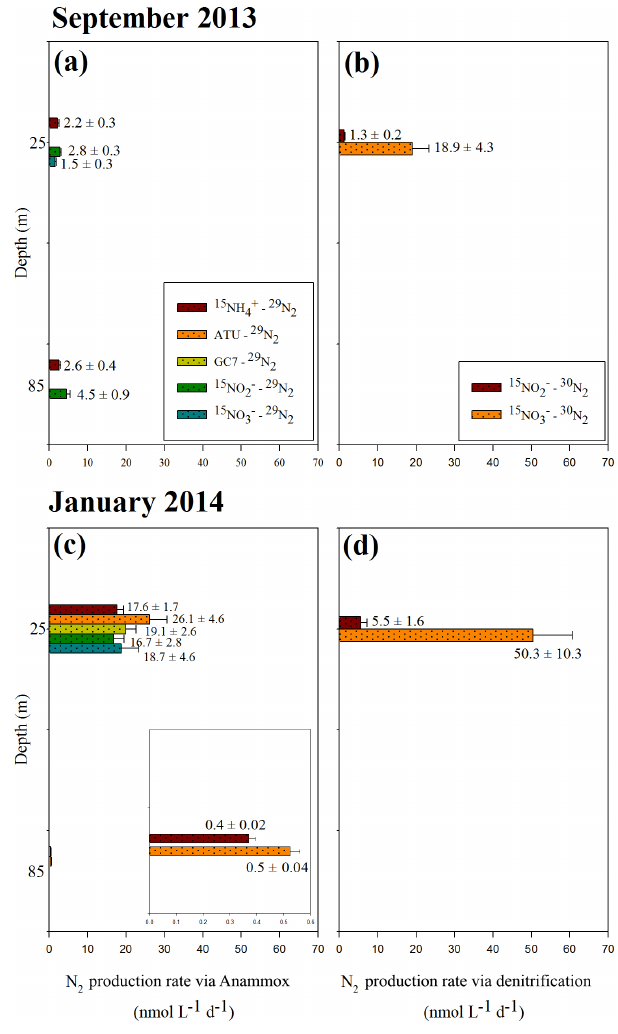
Figure 3. Anammox (a, c) and denitrification (b, d) activities ex- pressed as N 2 production rates measured in the oxycline (25m depth) and bottom layer (85m depth) at Sta. 18 over the continental shelf off central Chile during 12 September 2013 (a, b) and 28 Jan- uary 2014 (c, d) . Conventions show the amended tracer ( 15 NH + 15 NO − ) , isotopic pairing in the gas produced, and in- , and 15 NO − 2 3 hibitor when used (ATU and GC7). Inset in (c) represents details of lower values at